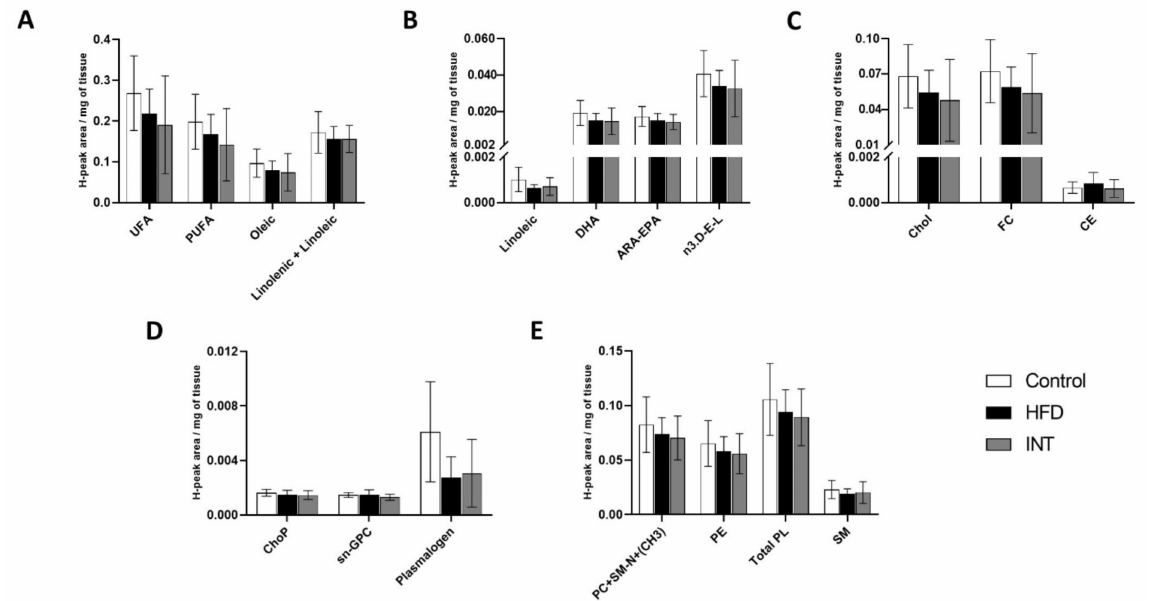
Figure 3. Alterations in metabolite lipid profile in hypothalamus. Representation of the changes induced by HFD and the nutritional and exercise intervention following the HFD, on the presence of ( A , B ) fatty acids, ( C ) sterol lipids and ( D , E ) phospholipids and sphingolipids. Ctrl n = 7, HFD n = 8, INT n = 8. Y-axis values indicate H-peak area/mg of tissue. Data represented as mean ± SEM, one-way ANOVA and post-hoc Tukey’s